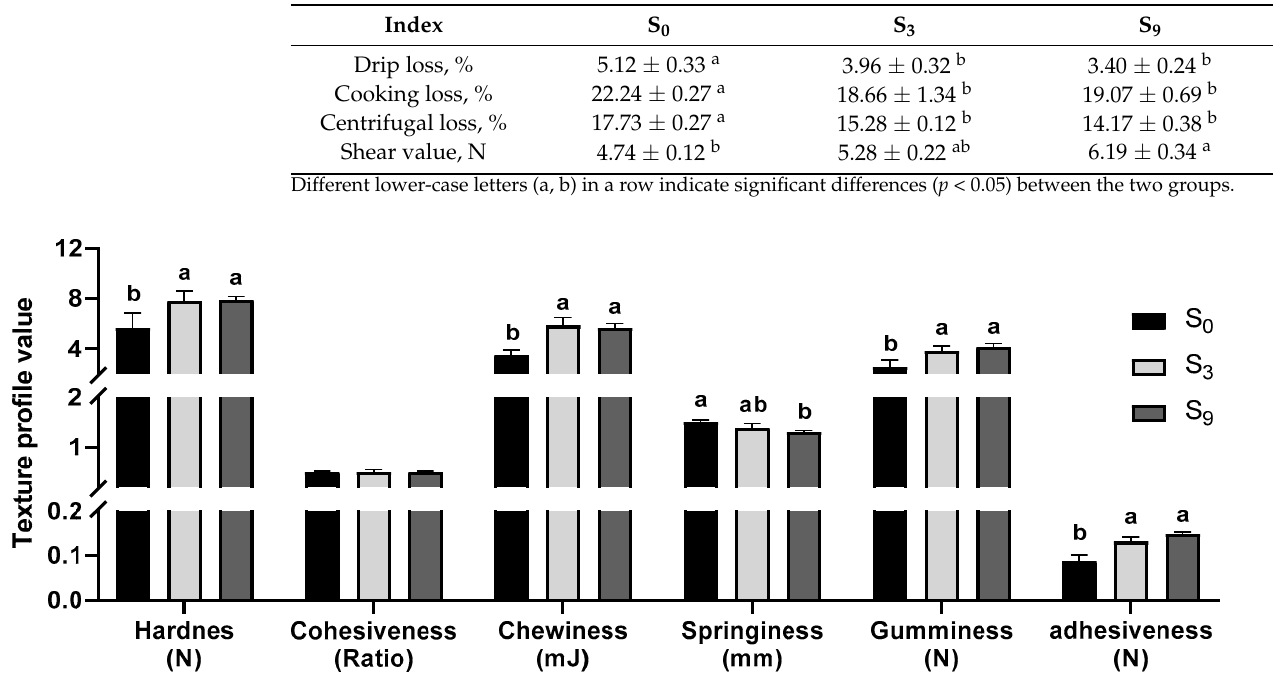
Figure 1. Effect of salinity on muscle texture profile in largemouth bass. Different lowercase letters indicate significant differences amone the treatment ( p < 0.05). The same as below.